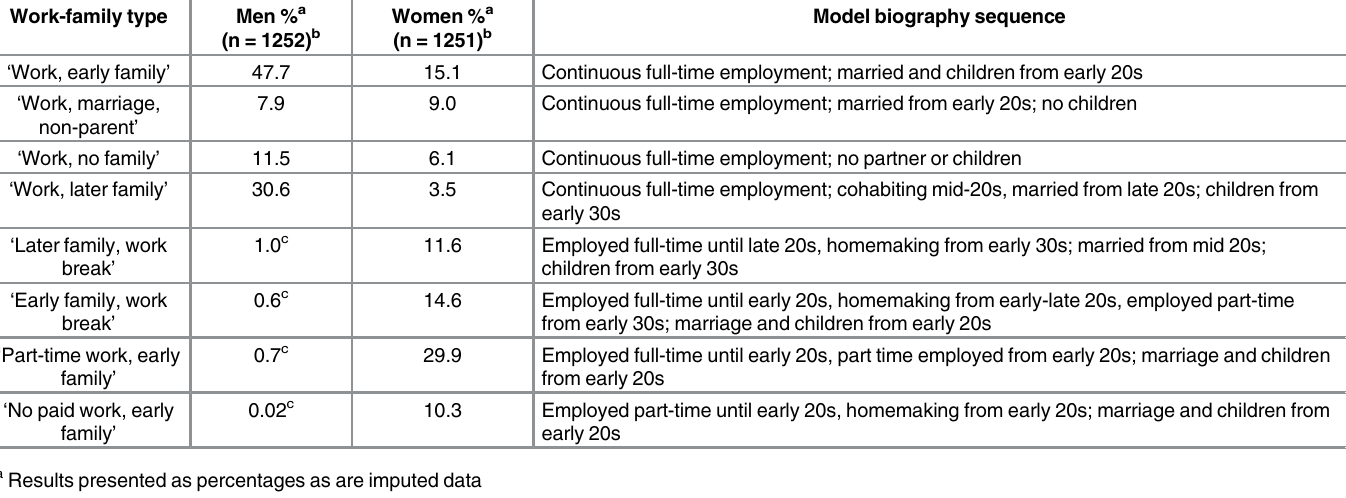
Table 1. Distribution of Work-Family Life Course Types and Associated Model Biographies in the